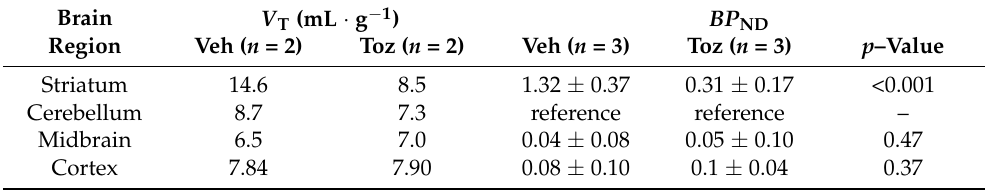
Figure 6. Mean parametric maps of the V T (mL · g −1 ) maps (left, n = 2) and the corresponding BP ND maps (right, n = 3) of control and tozadenant–treated pigs. Table 7. Mean estimates of total distribution volume ( V T ; Logan plot) and BP ND (SRTM, cerebellum reference region) in pig brain volumes of